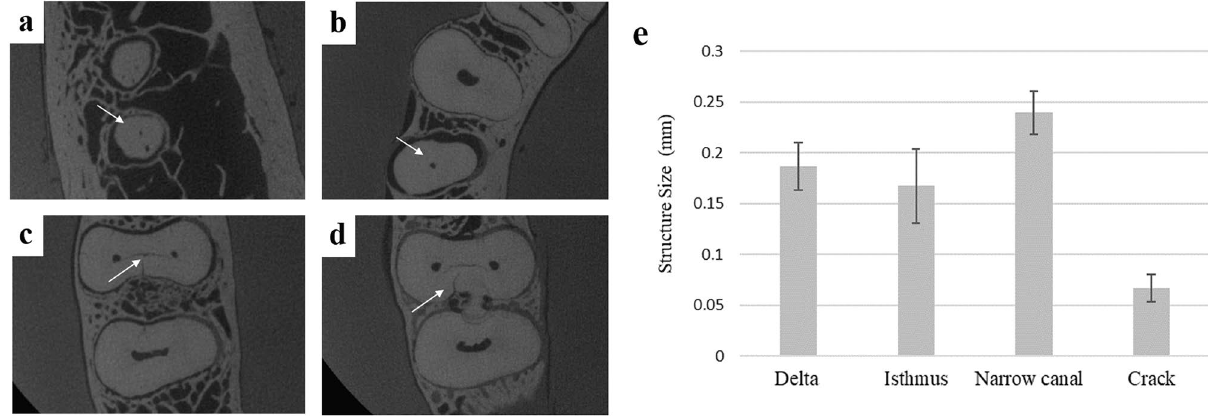
Figure 1. Representative images obtained from industrial CT showing ( a ) delta ramifications, ( b ) narrow canal, ( c ) isthmus and ( d ) crack used as reference images, and ( e ) bar chart showing the means and standard deviations of the size of these